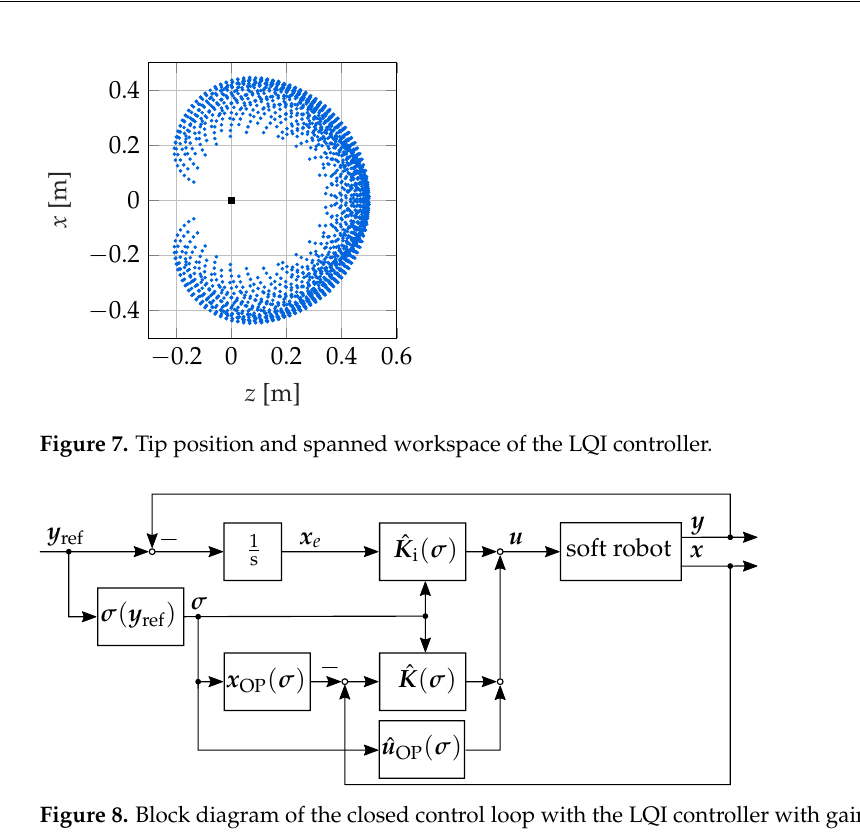
Figure 8. Block diagram of the closed control loop with the LQI controller with gain